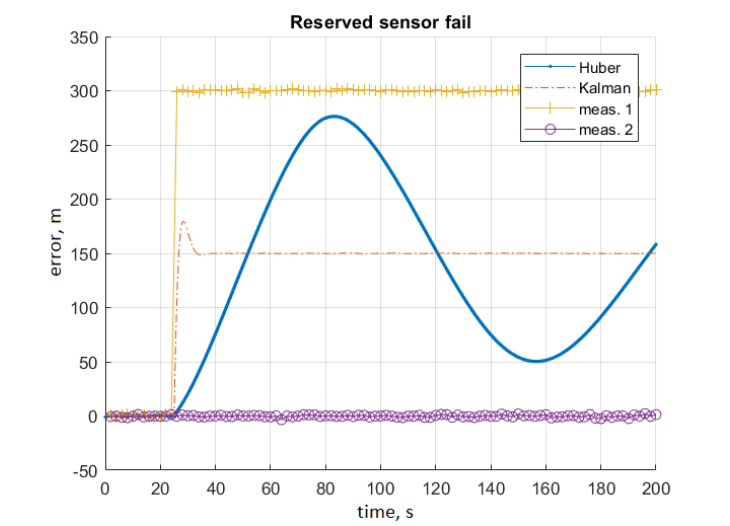
Figure 2. Estimate response to step error in measurements from a backup measurements